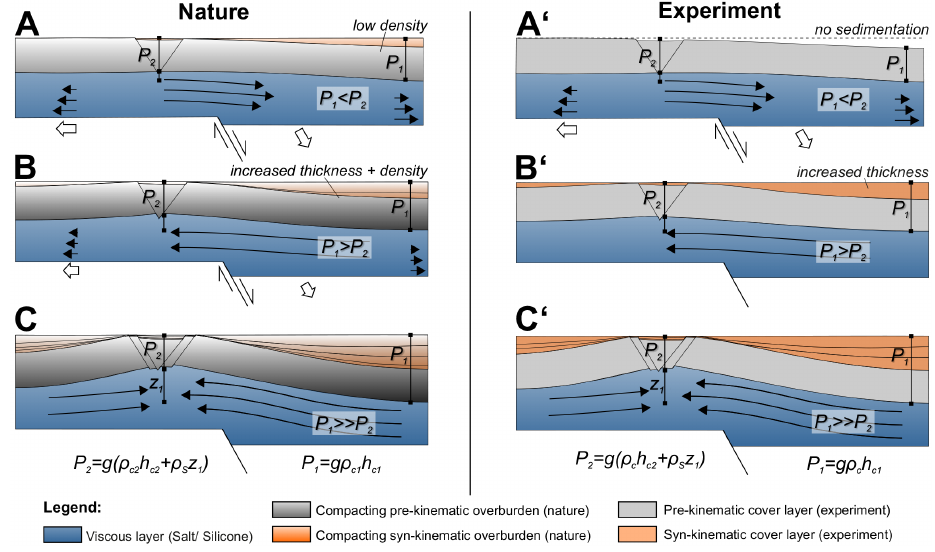
Figure 13. Conceptual model of the formation of a pillow and corresponding flow patterns in nature and experiment. (a) During initiation of basement faulting average density of the overburden in the HPS is still lower than that of salt causing only a low amount of differential loading. (a’) This is similar to the lack of sedimentation in the experimental peripheral sinks. In both cases downward flow occurs above the fault tip since the pressure head is smaller than the elevation head. (b) Due to further basement extension, thickness and density of the overburden above hanging wall side increase. (b’) Additional cover material is filled into the HPS. In both cases, upward flow above the basement fault is initiated by an increasing pressure head. (c/c’) During decreased or stopped extension, the viscous material can continuously flow upward causing the formation of a pillow